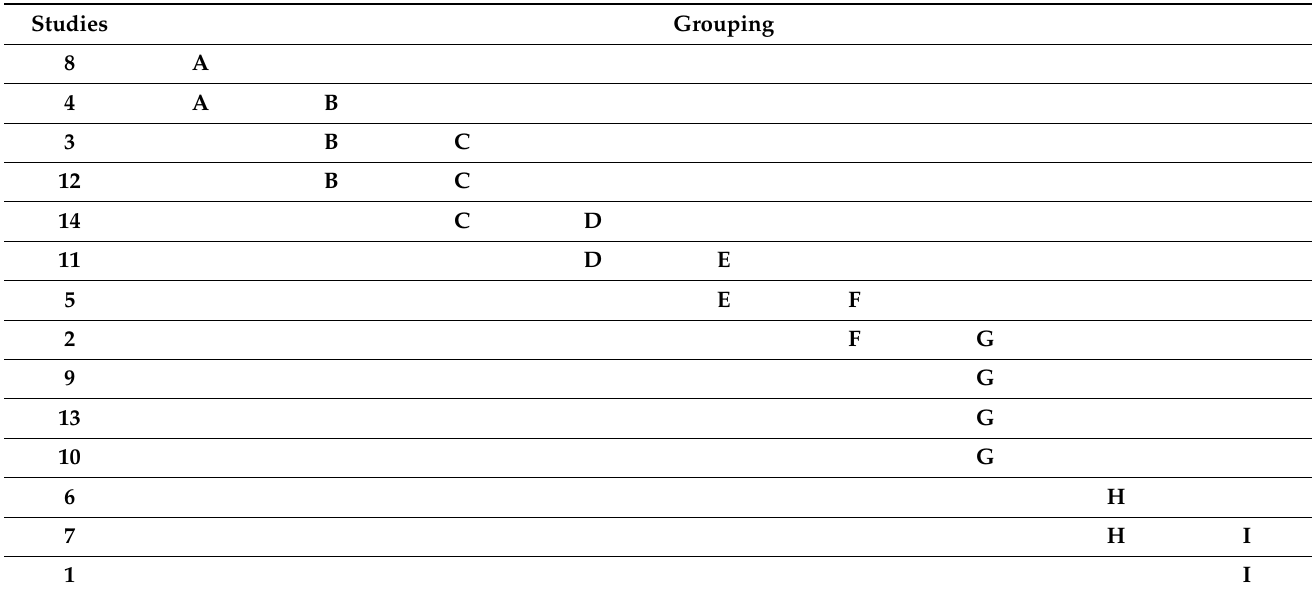
Table 6. Tukey’s statistical analysis among studies with the highest accuracy (%), with p > 0.05 at 95% CI. The study groups presented these results with the same